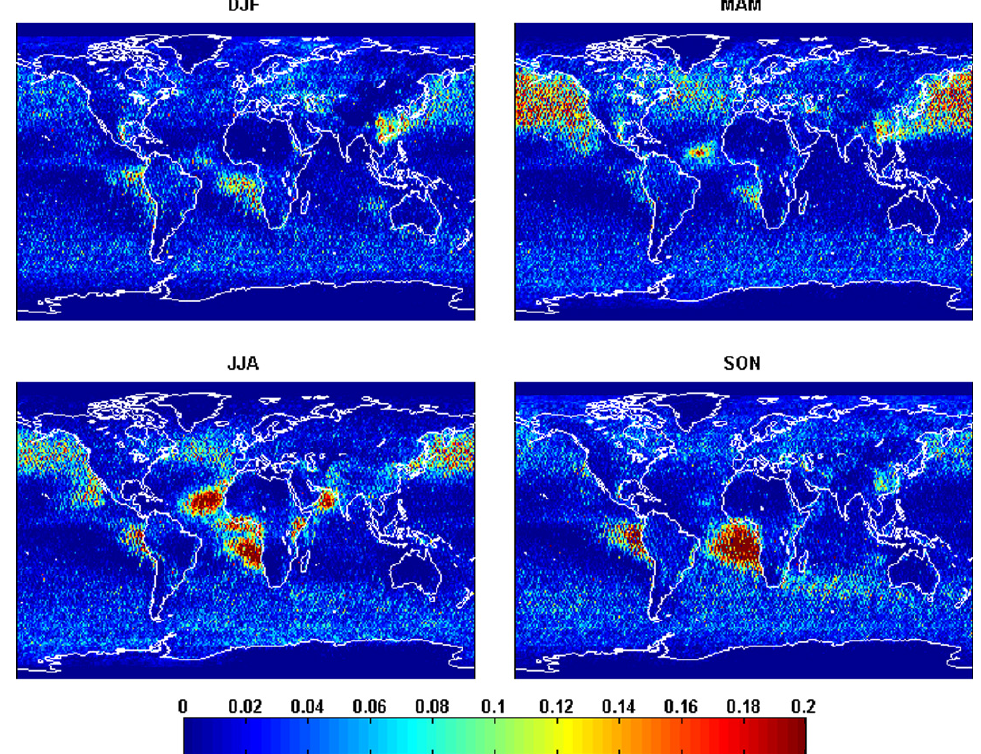
Fig. 3. The spatial and seasonal aerosol-water cloud overlap frequency when all aerosol types are considered for the analysis.